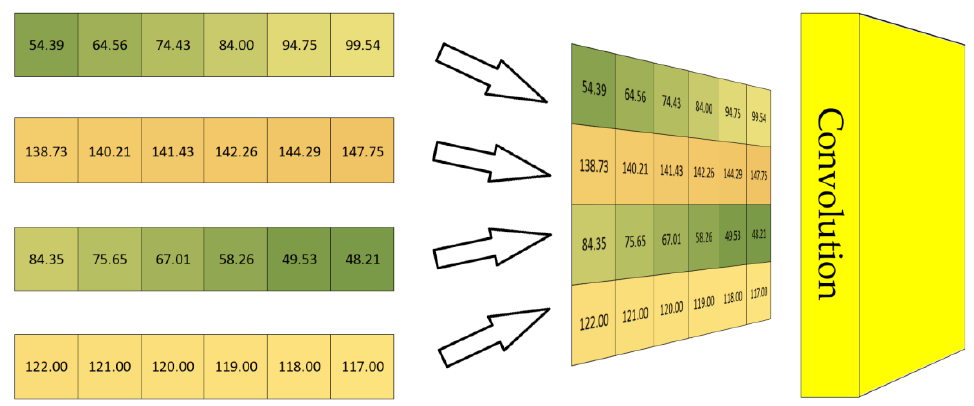
Figure 7. An example of the transformation of four time series into a two-dimensional variable.